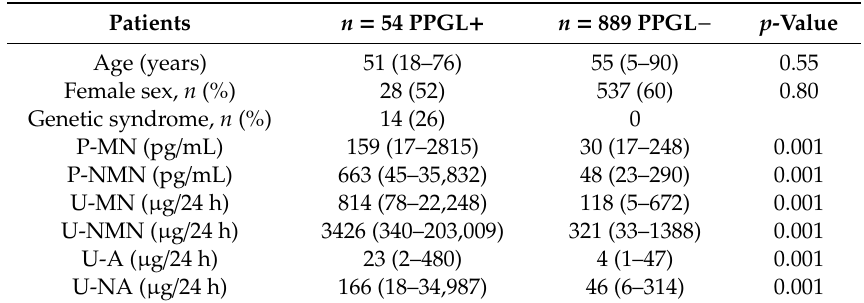
Table 3. Characteristics of the study population of n = 943 patients and concentrations of biochemical parameters (median and absolute